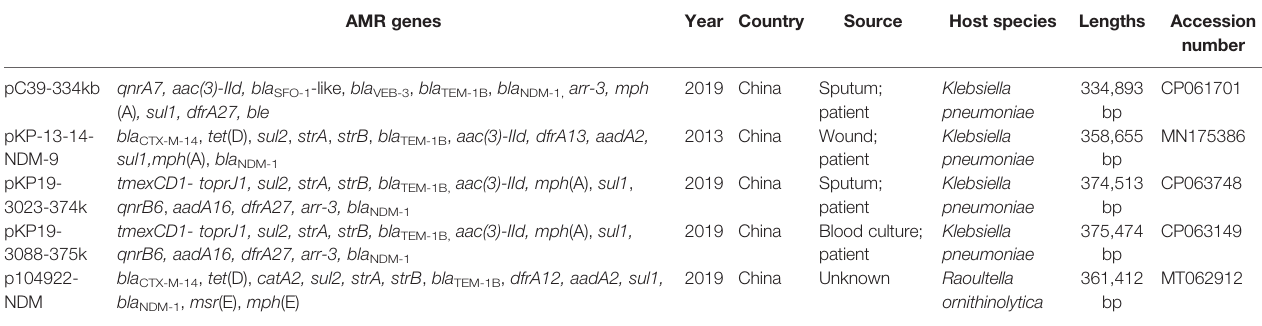
TABLE 2 | Basic information of fi ve IncHI5-like plasmids investigated in this